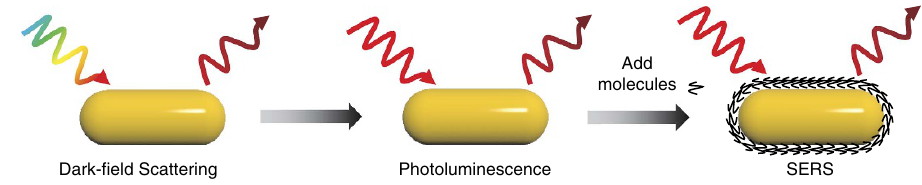
Figure 1 | Schematic diagram for the quantitative experimental study. To correlate the LSPR, PL and SERS of single nanorods, the dark-field scattering and the PL signal are first measured in the absence of molecules, and SERS spectra were then measured after molecules